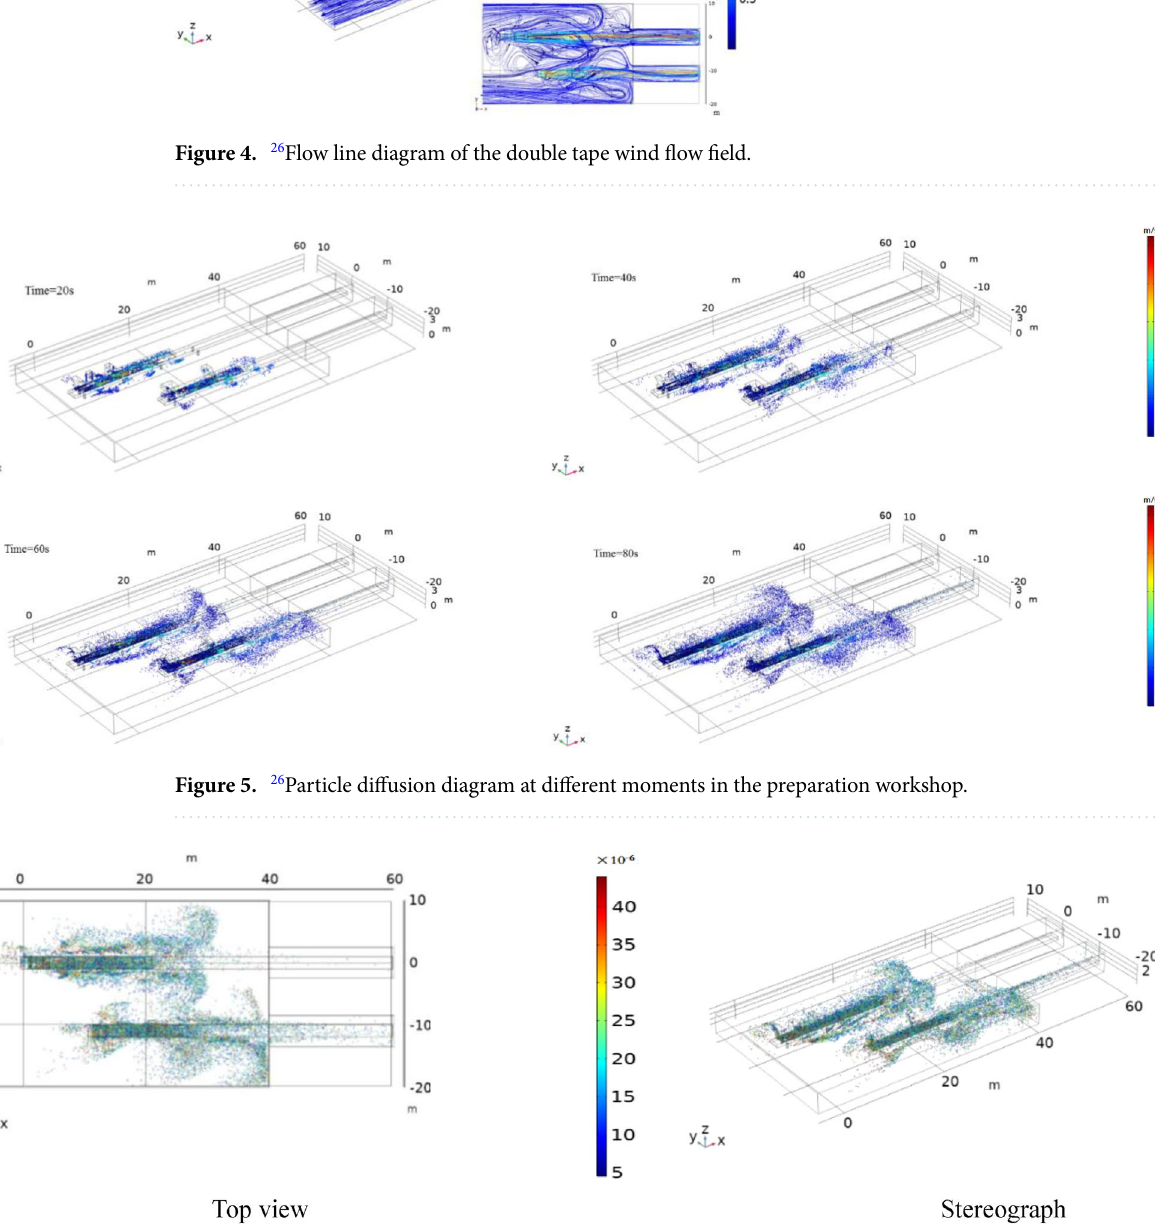
Figure 6. 26 Particle size distribution